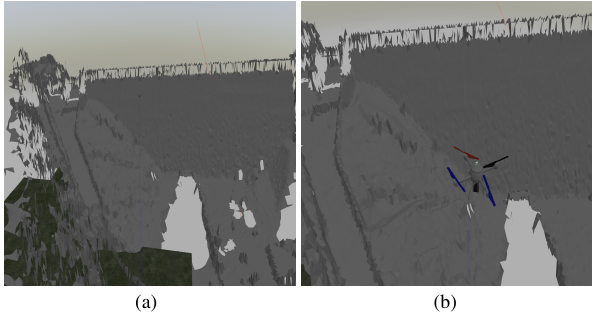
Figure 14. simulation with real data from Guerledan dam